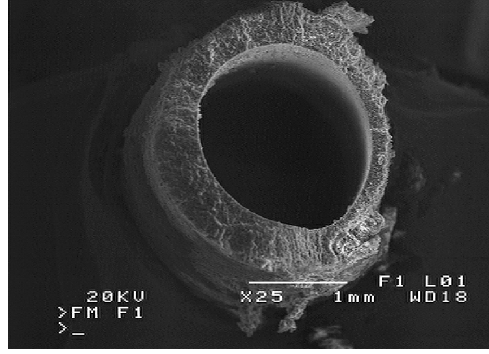
Figure 10. SEM image of membrane cross-section. Membrane sample from MD2 module.